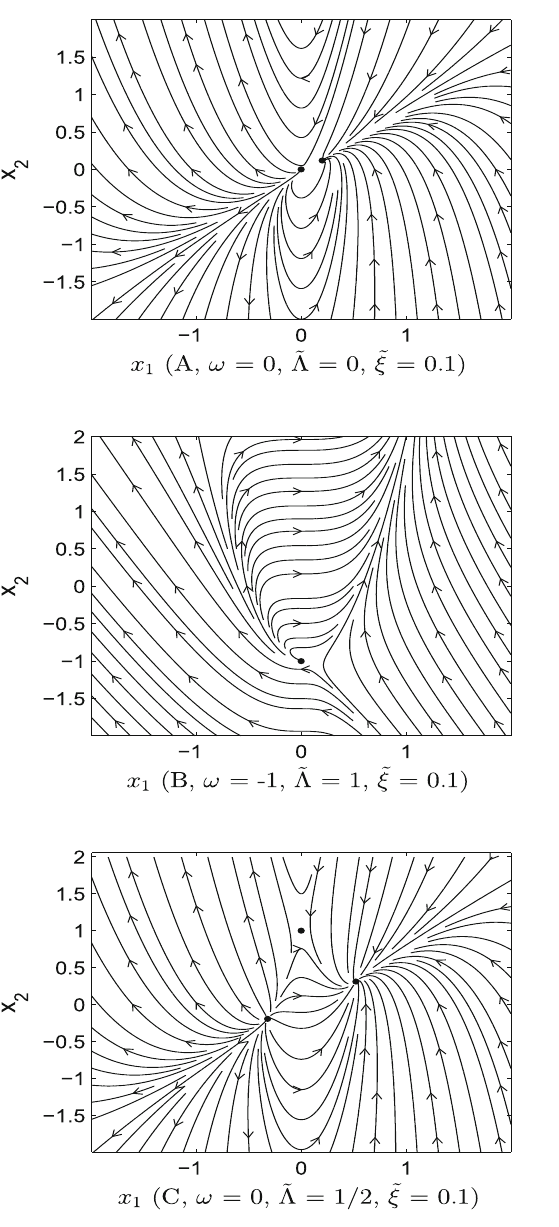
Fig. 12 Uncompact (left panel) and compact (right panel) phase por- respectively denote the dimensionless ˜ H and ˜ ρ as defined in Eq. (7). X traits when viscosity is included, ˜ ξ = 0 . 1. Representative cases are (cid:11) and Y are the coordinates on the Poincaré sphere as defined in Eq. (47). (cid:12) (cid:11) (cid:12) (cid:11) (cid:12) The dotted circles represent fixed ω = 0 , ˜ (cid:4) = 0 ω = − 1 , ˜ (cid:4) = 1 ω = 0 , ˜ (cid:4) = 0 . 5 , and . x 1 and x 2